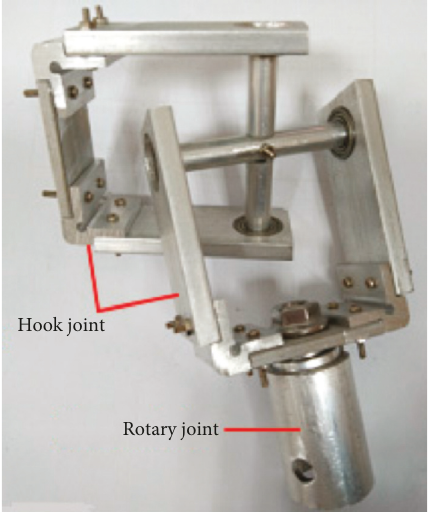
Figure 8: Structure of the smart compound